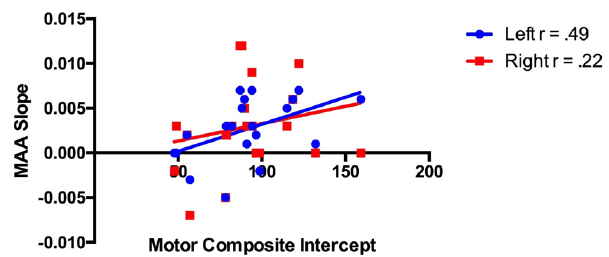
Figure 15. Scatter plot of mean average acceleration (MAA) slopes (for right and left arms) and Bayley composite motor intercepts of each